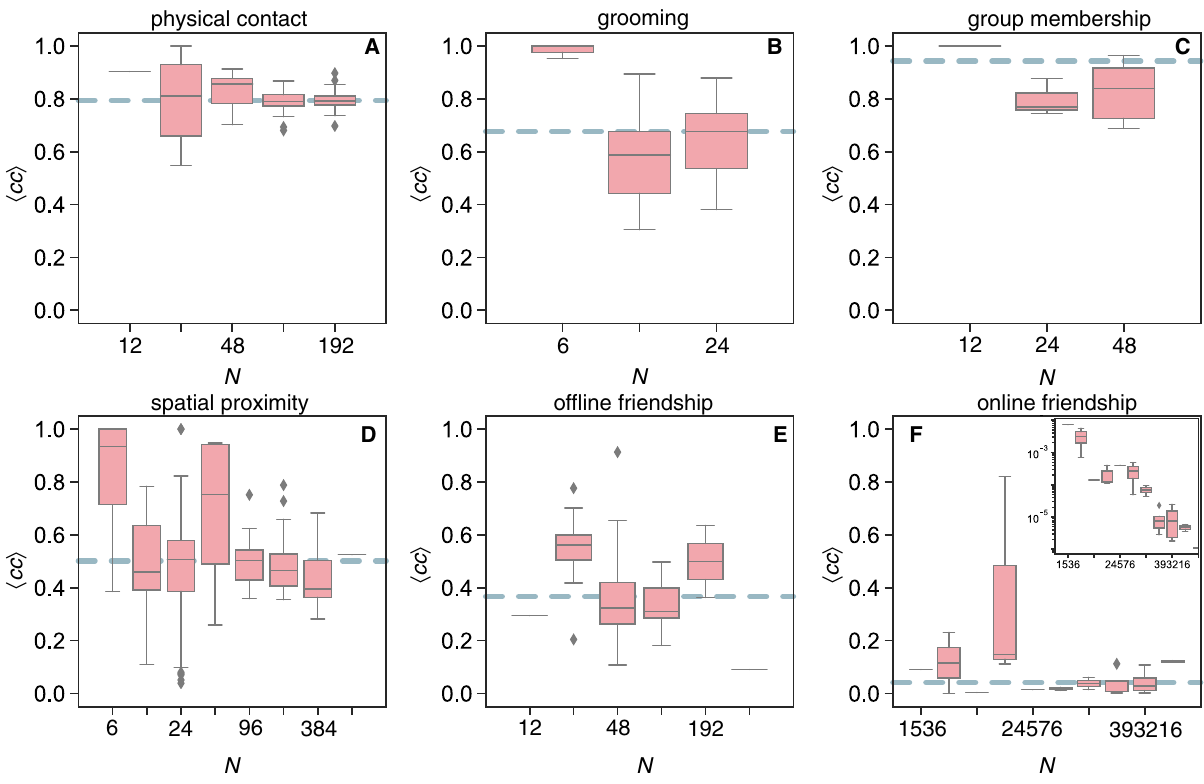
Figure 2. Network clustering structures. The average clustering coefficient (cid:31) cc (cid:30) between close contacts vs. network size for ( A ) physical contact (median values for the empirical M emp = 0.94 and randomised M rand = 0.88 versions of the same networks); ( B ) grooming ( M emp = 0.68 and M rand = 0.56 ); ( C ) group membership ( M emp = 0.79 and M rand = 0.69 ); ( D ) spatial proximity ( M emp = 0.50 and M rand = 0.22 ); ( E ) offline friendship ( M emp = 0.37 and M rand = 0.07 ); ( F ) online friendship ( M emp = 0.04 and M rand = 3.5 · 10 − 5 ); the inset is the distribution for the random version of the same networks. Dashed horizontal lines are the median values of the empirical networks. Log-binned (x-axes) Tukey box plots with diamonds representing